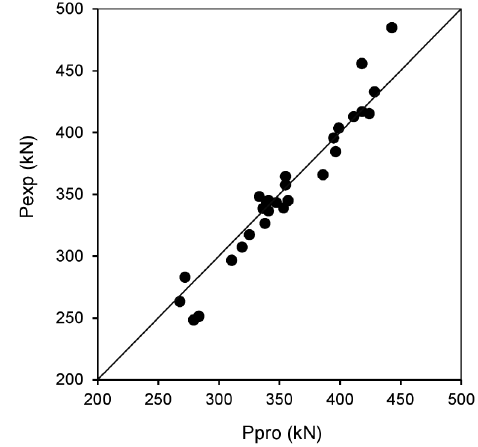
Fig. 6. Experimental and proposed load-carrying capacity of PSTC specimens